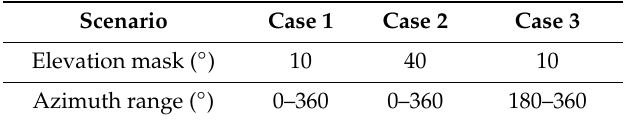
Table 4. Three scenarios with di ff erent elevation and azimuth